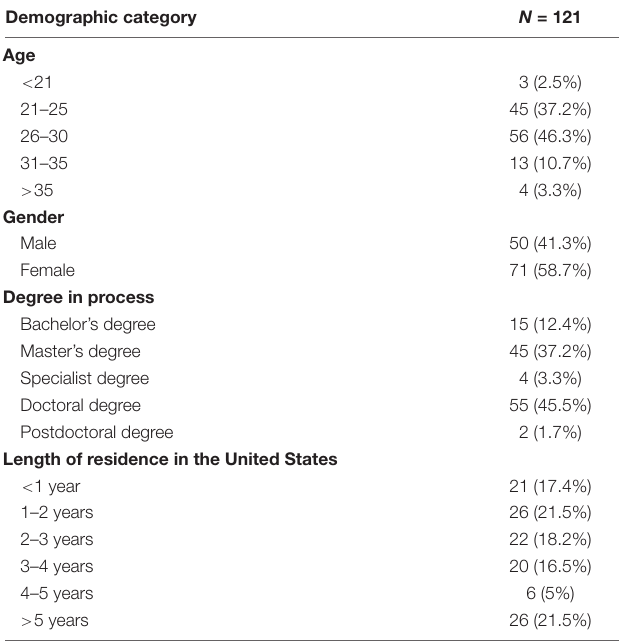
TABLE 1 | Summary of participants’ descriptive